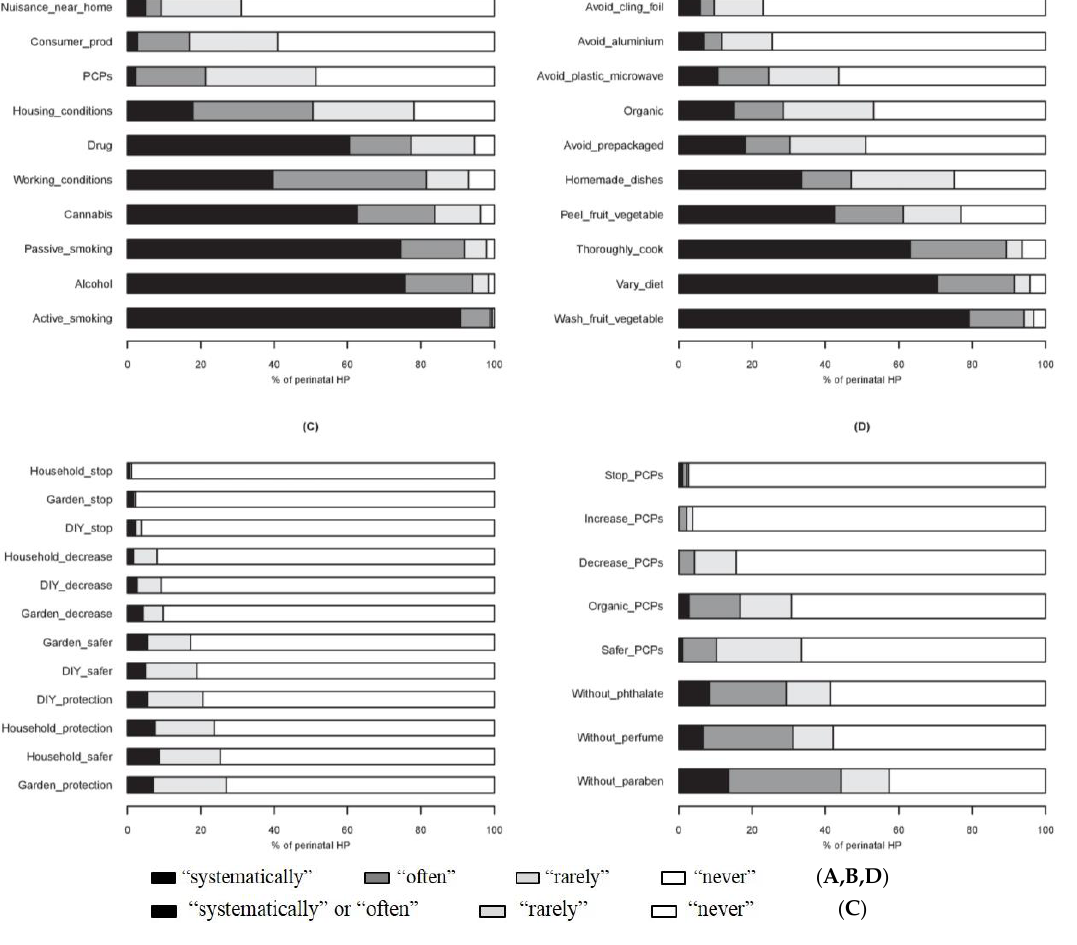
Figure 4. Attitude of perinatal HPs towards exposure of pregnant women to chemicals: spontaneous questioning about exposure factors ( A ); dietary advice ( B ); advice on the use of consumer products ( C ); and personal care products ( D ). Avoid_plastic_microwave, avoid micro-waving in plastic dishes; Consumer_prod, consumer products (corresponds to household, DIY and gardening products); HP, health professionals; PCPs, personal care products.